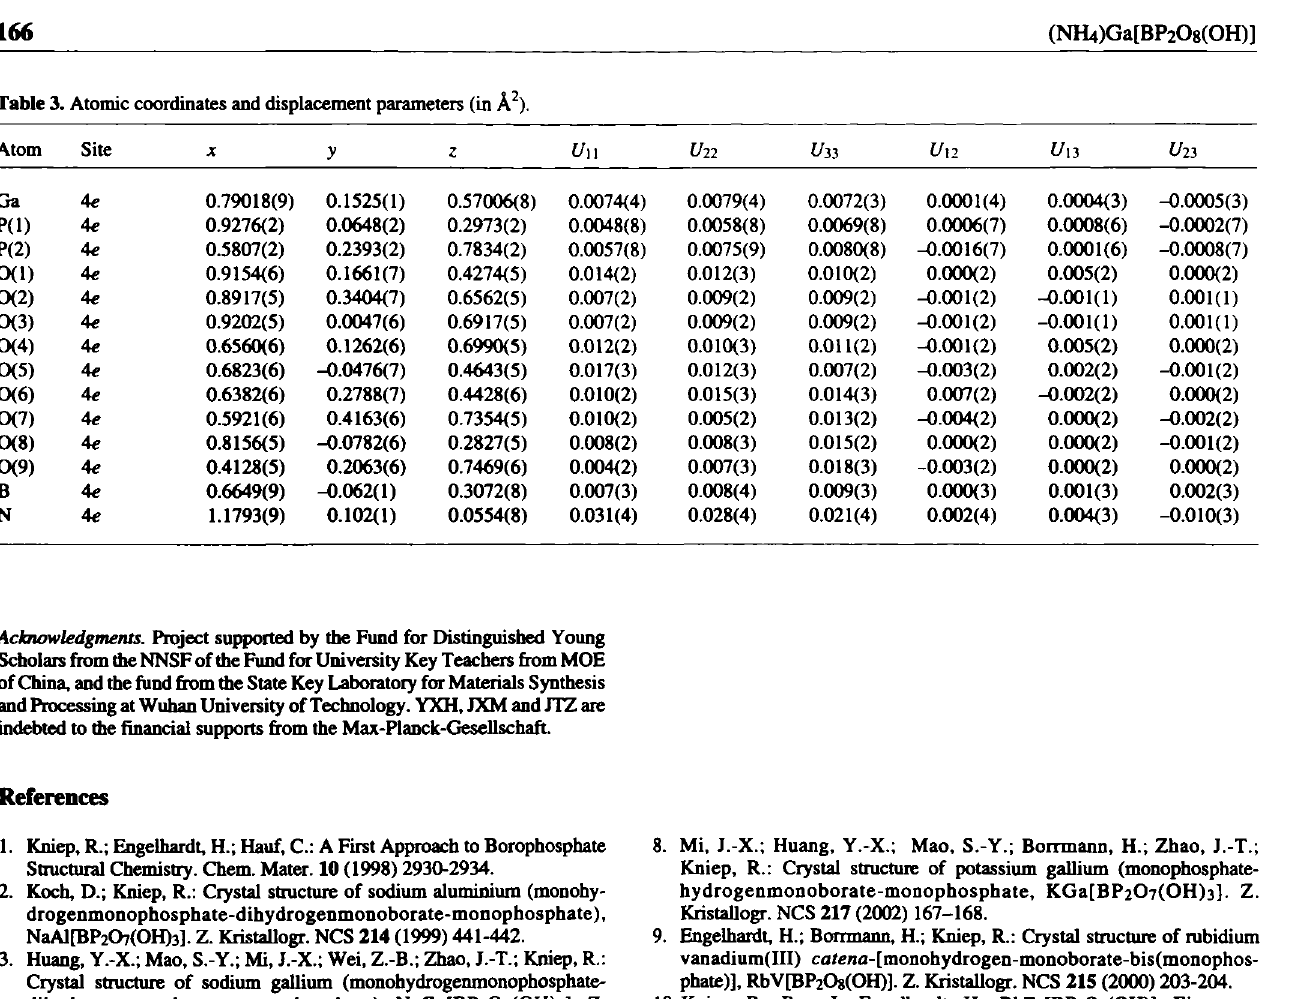
Table 3. Atomic coordinates and displacement parameters (in Â 2